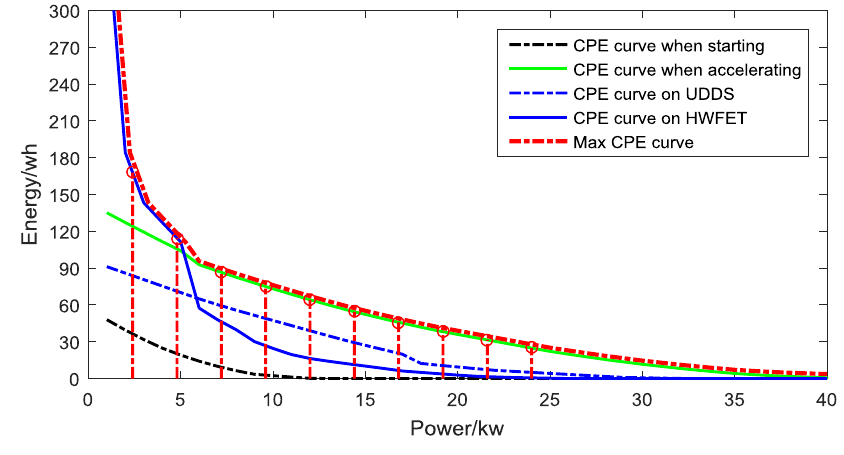
Figure 13. CPE curves on driving cycles and special phases.